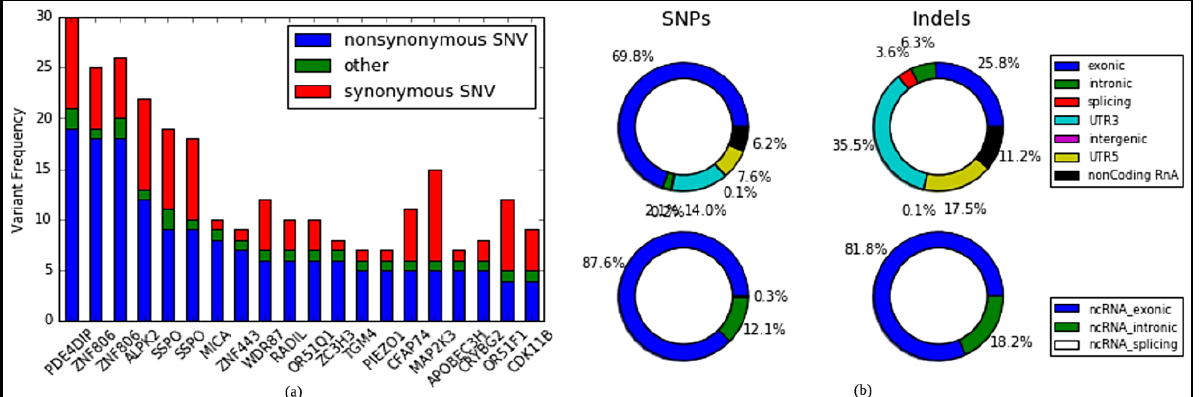
Figure 3. WES analysis result intra-person visualization: (a) SNP frequency types (synonymous/non-synonymous/other) per gene for the 20 genes with the most variants and the pie charts (b) frequency of detected variants in the same sample, divided in SNPs and indels and per variant type.